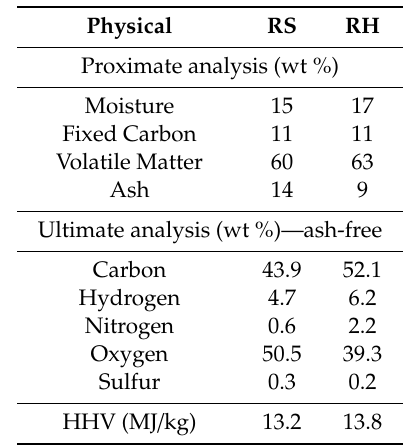
Table 7. PA, UA, and HHV of RS and RH pellets.